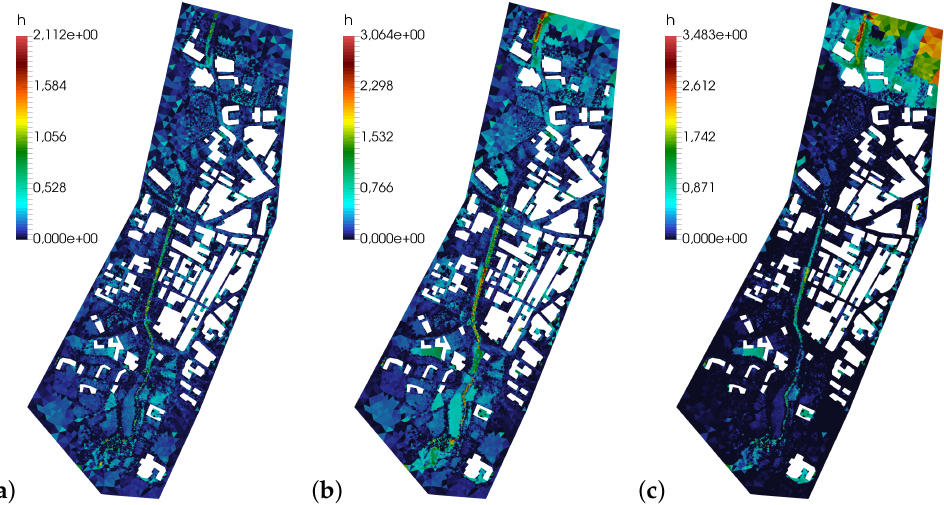
Figure 12. Case 2.1. Water depth values ( h ) in m at t = 150 s ( a ), 300 s ( b ) and 3000 s ( c